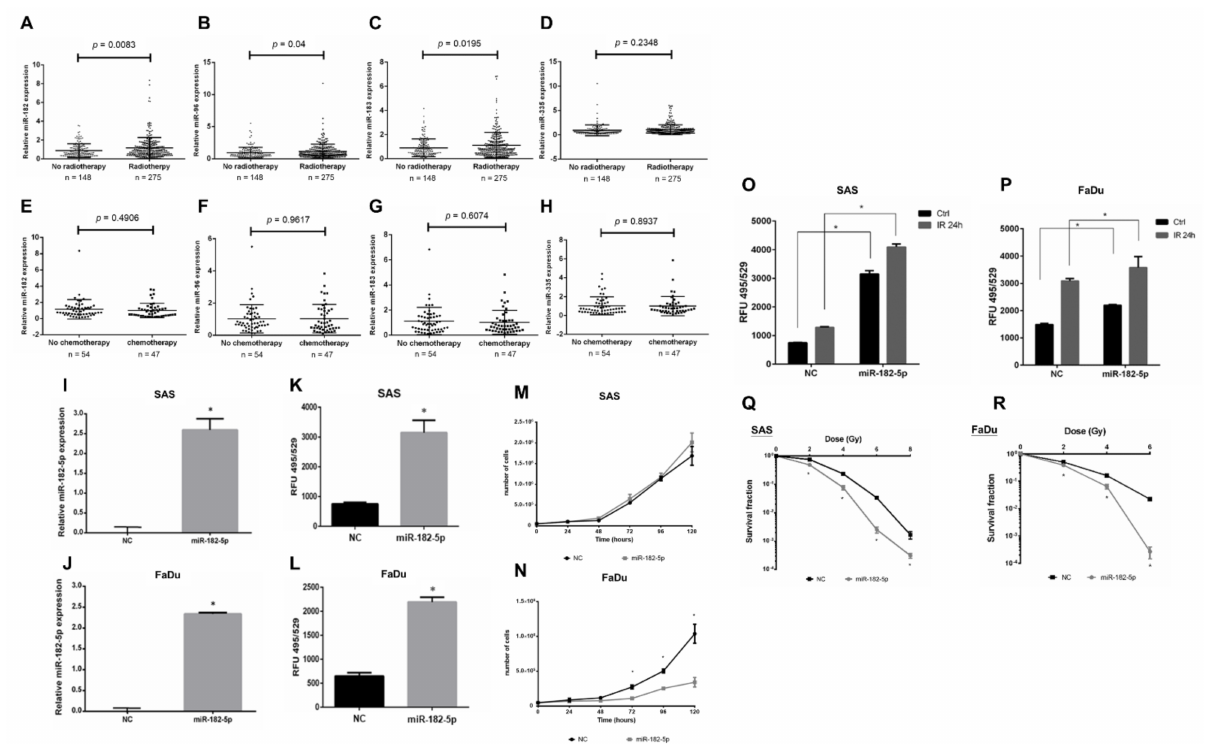
Figure 2. Effects of high miR-182 expression on the radiosensitivity of HNSCC cells. ( A – D ) Expression of miR-182, miR-96, miR-183 and miR-335 in HNSCC patients with or without radiotherapy using the TCGA-HNSC dataset. ( E – H ) Expression of miR-182, miR-96, miR-183 and miR-335 in HNSCC patients with or without chemotherapy using the TCGA-HNSC dataset. ( I , J ) qPCR analysis of miR-182-5p expression in SAS cells and FaDu cells transduced with the pGIPZ-lentiviral shRNAmir constructs, respectively. ( K , L ) Quantification of the ROS levels in cells with or without overexpression of miR-182-5p using the DCFDA method. ( M , N ) Comparison of cell growth rates between cells with and without overexpression of miR-182-5p. ( O , P ) Comparison of radiation effects (IR: 8 Gy) on the intracellular ROS level in cells with or without overexpression of miR-182-5p. ( Q , R ) Analysis of surviving fractions of SAS cells and FaDu cells exposed to different doses of X-rays with or without miR-182-5p overexpression, respectively. *: p <